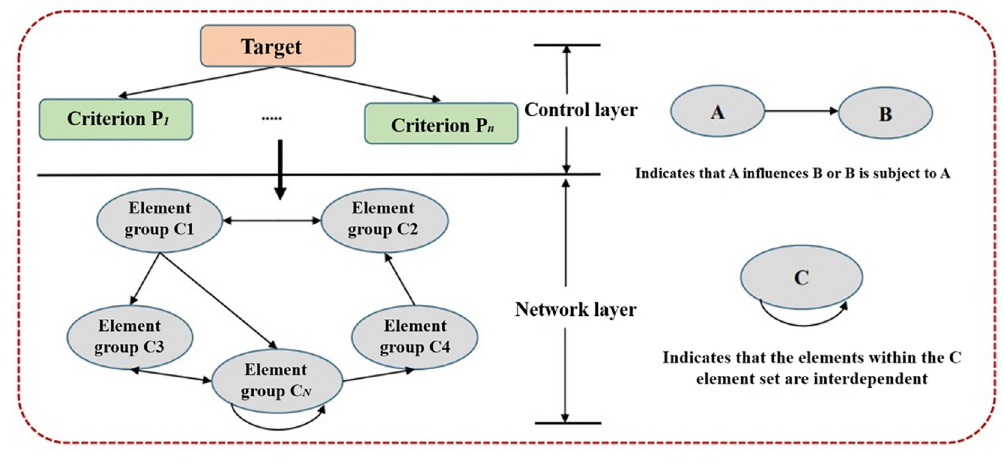
Fig 18. Typical ANP structure diagram.